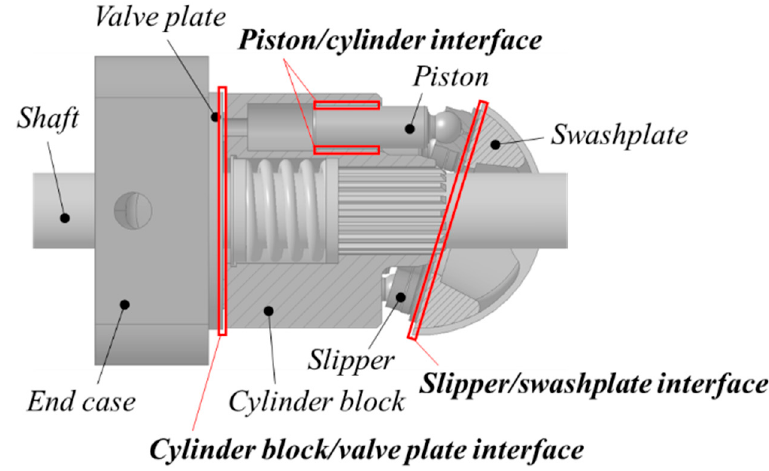
Figure 1. Three lubricating interfaces.